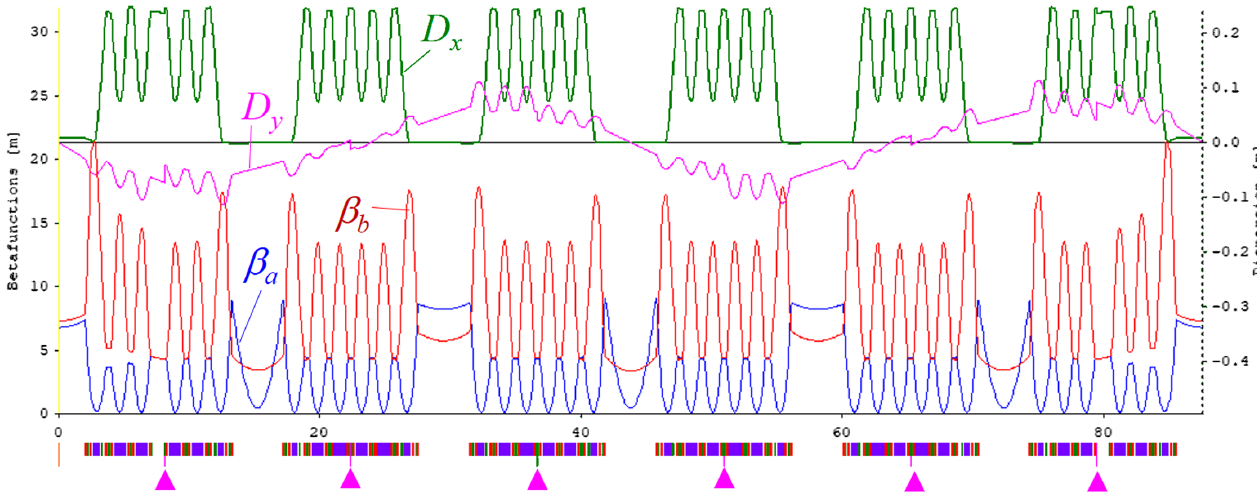
FIG. 3. Optics of the Spiral COSAMI lattice showing normal mode beta functions (left axis) and physical dispersions (right axis). The triangles at the bottom indicate points of rotations by angles f − β ; α ; α ; α ; α ; − β g with α ¼ 3 . 86 °, β ¼ 7 . 69